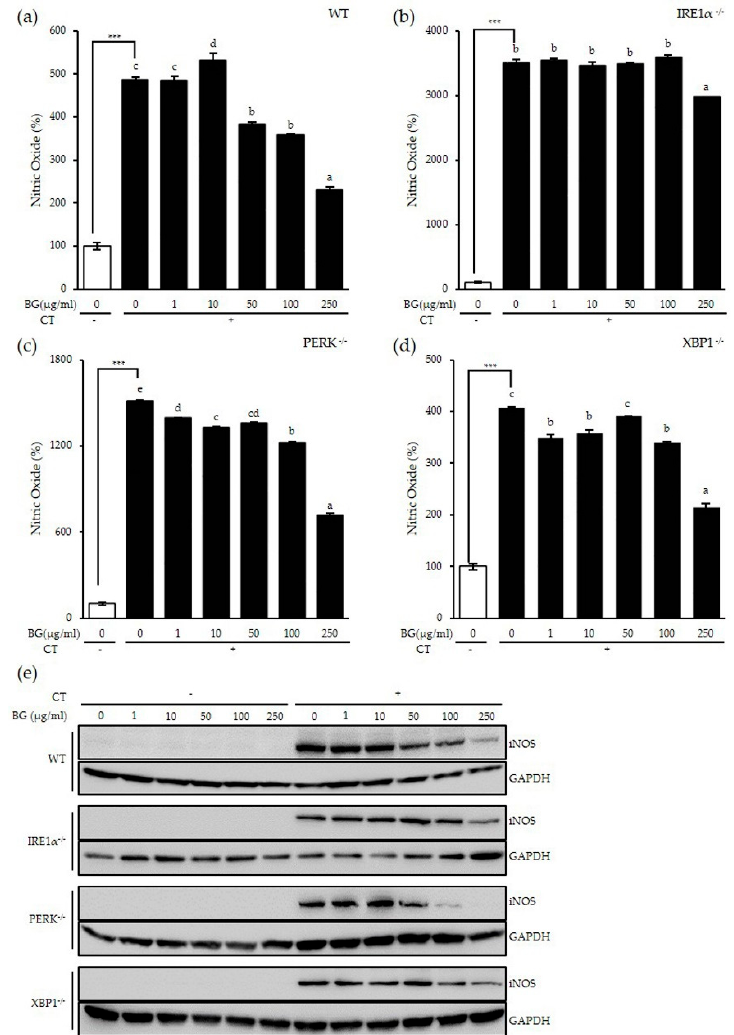
Figure 2. Inhibitory effect of BG on CT ‐ induced nitric oxide (NO) production and induced NO synthases (iNOS) expression in an inositol ‐ requiring enzyme 1 (IRE1 α ) ‐ dependent way. The ( a ) wt, ( b ) IRE1 α knockout (KO), ( c ) protein kinase RNA (PKR) ‐ like endoplasmic reticulum ‐ resistant kinase (PERK) KO and ( d ) X ‐ box ‐ binding protein 1 (XBP1) KO MEF cell lines were pretreated with various concentrations of BG for 24 h followed by CT (50 ng/mL TNF ‐α + 50 ng/mL interferon (IFN) ‐γ + 25 ng/mL IL ‐ 1 β + lipopolysaccharides (LPS) 10 μ g/mL) stimulation for an additional 24 h. Conditioned media were harvested to measure NO levels ( a – d ); cell lysates were extracted for Western blot ( e ). Glyceraldehyde ‐ 3 ‐ phosphate dehydrogenase ( GAPDH ) was the loading control.